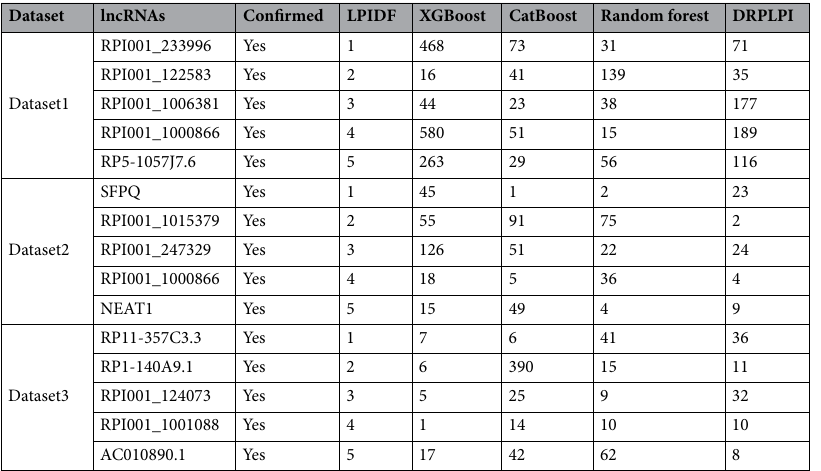
Table 7. The predicted top 5 lncRNAs interacting with